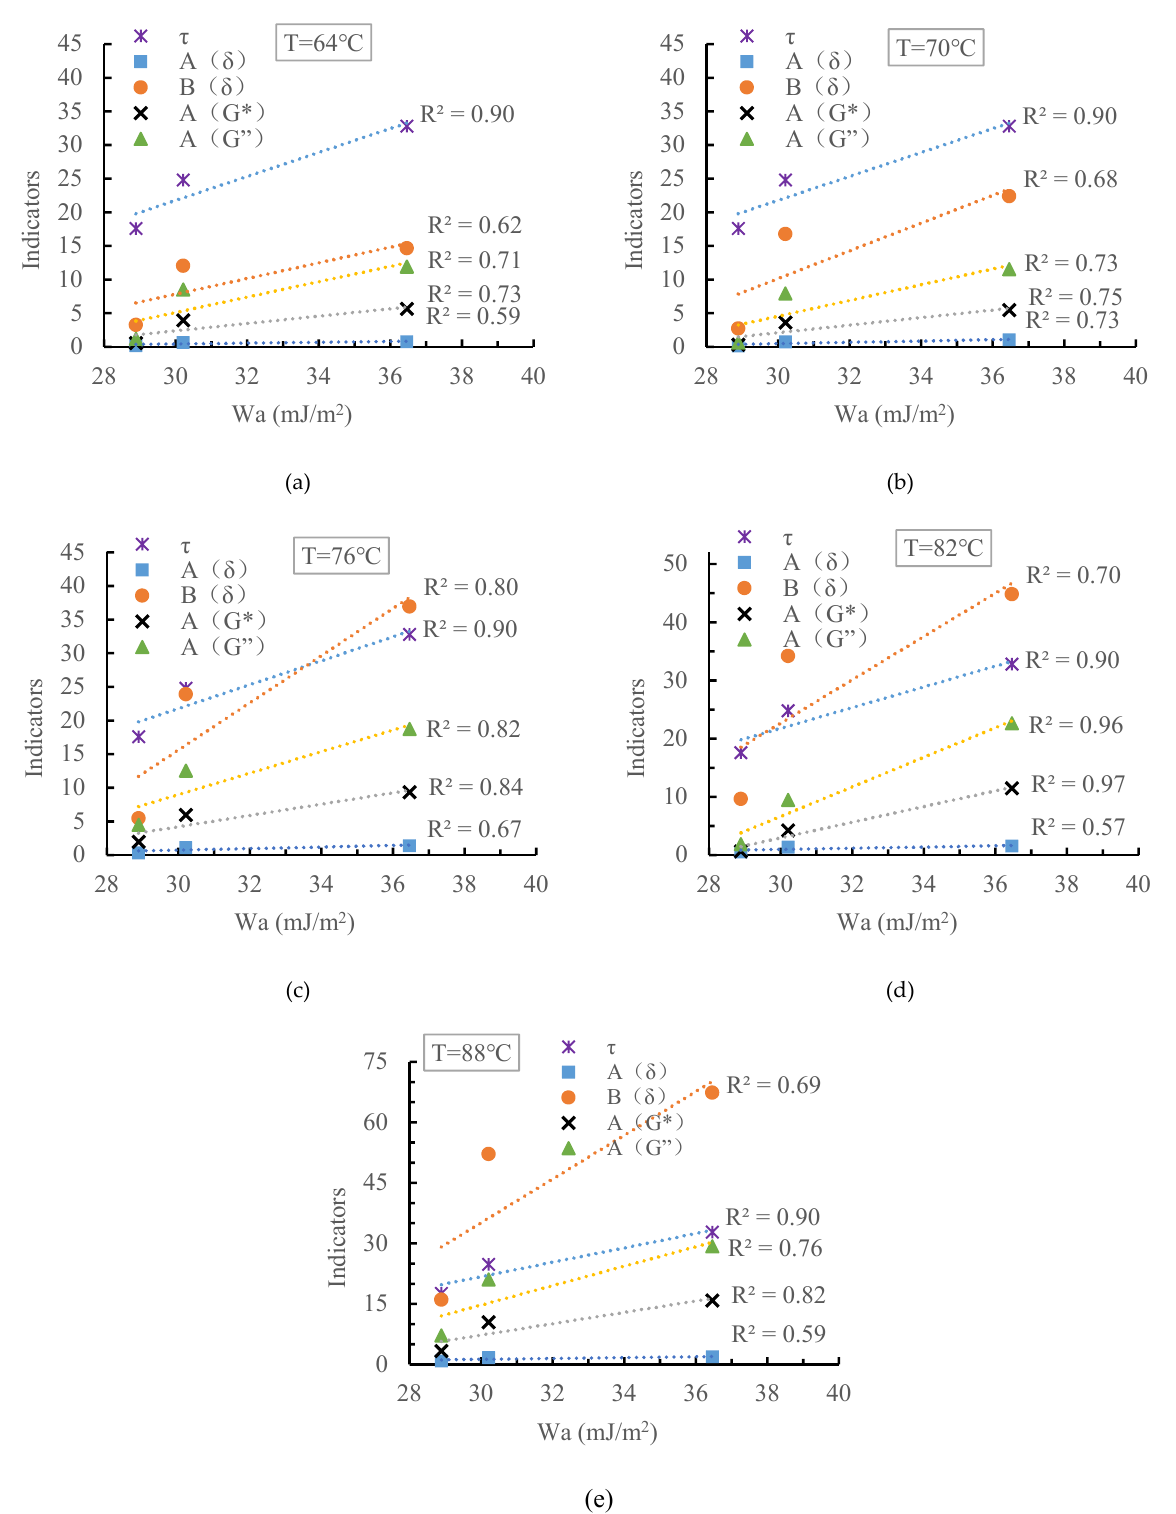
Figure 10. The correlation between adhesion work and other indicators at ( a ) 64 °C, ( b ) 70 °C, ( c ) 76 °C, ( d ) 82 °C and ( e ) 88 °C.